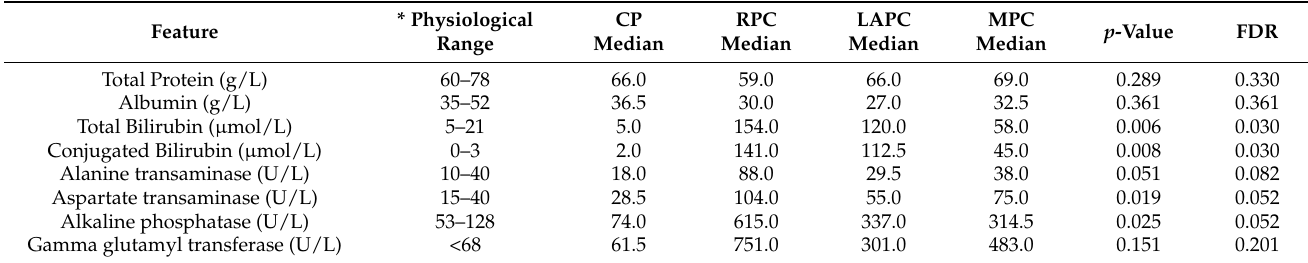
Table 2. Liver Function Tests of the Chronic Pancreatitis and Pancreatic Ductal Adenocarcinoma groups.